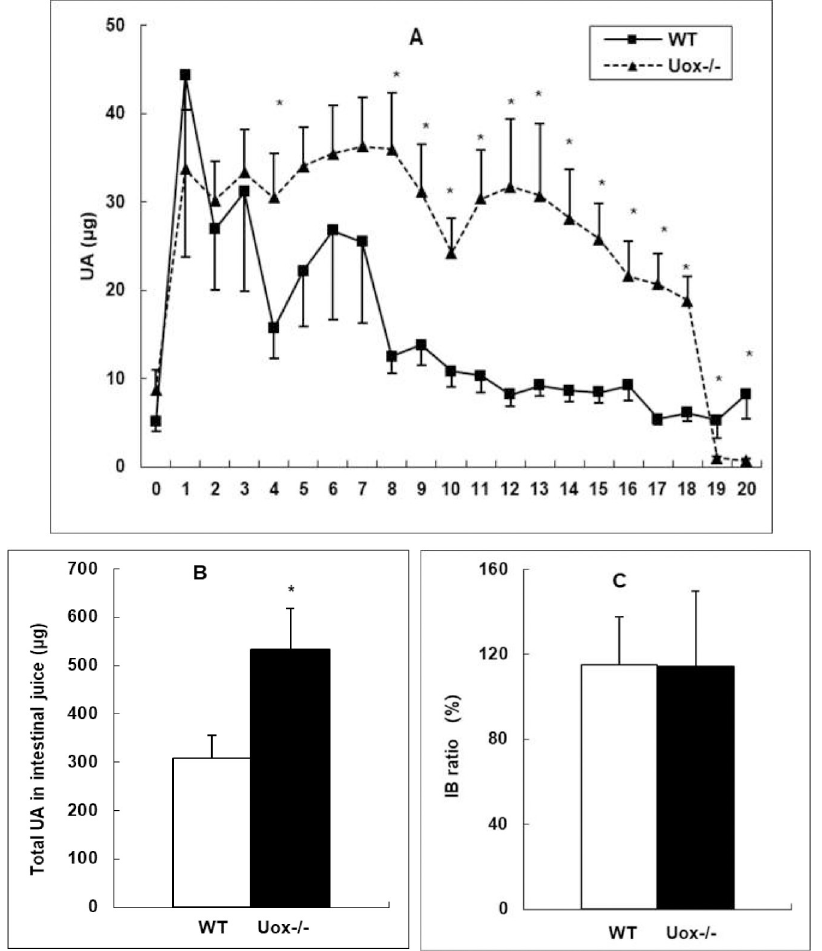
Fig 5. Uric Acid (UA) in the Wild-Type (WT) and Uox -/- (Uox -/- ) rats’ gastrointestinal juice who weighing 180– 220 g (mean ± SD, n = 10). A, Rats’ intestinal tract except cecum was equally divided into 20 segments, and uric acid in the intestinal juice was assayed. Segment 0 was the stomach, segment 1 was the duodenum, segments 2 to 7 were the jejunum, segments 8 to 18 were the ileum, and segments 19 to 20 were the colon. In all the groups, the uric acid distribution curve arrived to the maximum at segment 1, and almost declined to the terminus. Compared with the distribution curve of the WT group, those of the Uox -/- group was almost parallelly increased to some extent. B, The total UA in intestinal juice in Uox -/- group significantly increased. C, UA IB ratio in the Uox -/- rats was similar to that in the WT rats. � P < 0.05 vs WT, one-way ANOVA. duodenum, lung, and spleen; the top four organs according to uric acid content in wild-type rats were the adrenal gland, duodenum, liver, and ileum. Since the intestinal tract is one of the important sites of uric acid distribution [15], uric acid was assayed in gastrointestinal tissues and juice. The content of uric acid in the gastrointestinal fluid was higher in the Uox -/- rats than in wild-type rats, except for the juice of the colon (seg- ments 19 and 20) (Fig 5A). The uric acid distribution pattern in the Uox -/- rats’ gastrointestinal juice was largely similar to that in wild-type rats’ [15], since the IB ratio (total uric acid in intes- tinal juice: by total uric acid in the blood; calculated by Formula-1) in the Uox -/- rats was close to that in the wild-type rats (Fig 5C), though the total uric acid in Uox -/- rats’ intestinal juice was much higher than that in the wild-type rats (Fig 5B). The uric acid content in the intestinal juice of a segment significantly correlated with that in the segment’s tissue (R = 0.274,